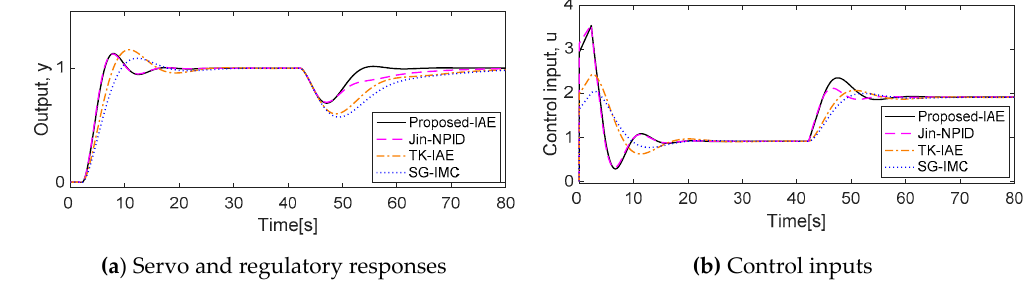
Figure 8. Servo and regulatory responses for process 1 under 10% mismatch. Table 3. Quantitative comparison of performances for process 1 under 10% mismatch.